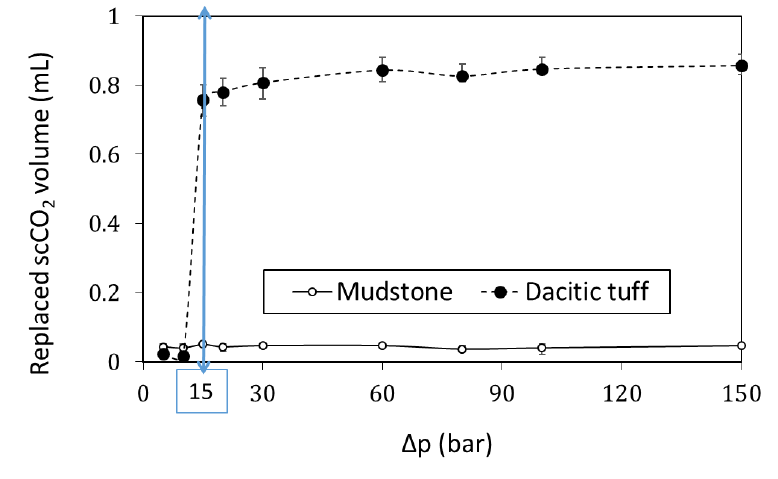
Figure 5. Initial scCO 2 capillary entry pressure (Δp) and the volume of scCO 2 stored in mudstone and dacitic tuff cores.